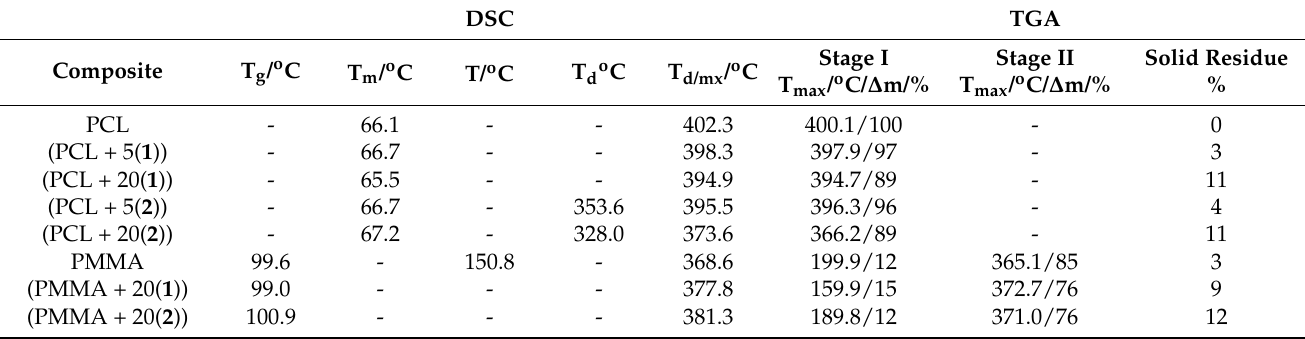
Figure 4. SEM images and EDX patterns of (PCL + 20( 1 )) and (PCL + 20( 2 )) composites, the pure PCL spectra are given for comparison. Table 2. Thermal parameters received from thermogravimetric analysis (TGA) and differential scanning calorimetry (DSC) of the composites (T g = glass transition temperature, T = evaporation temperature of an unreacted monomer, T m = melting temperature, T d/max = decomposition temperature (transition maximum), T max = temperature in the thermal transition maximum, ∆ m = thermal transition weight